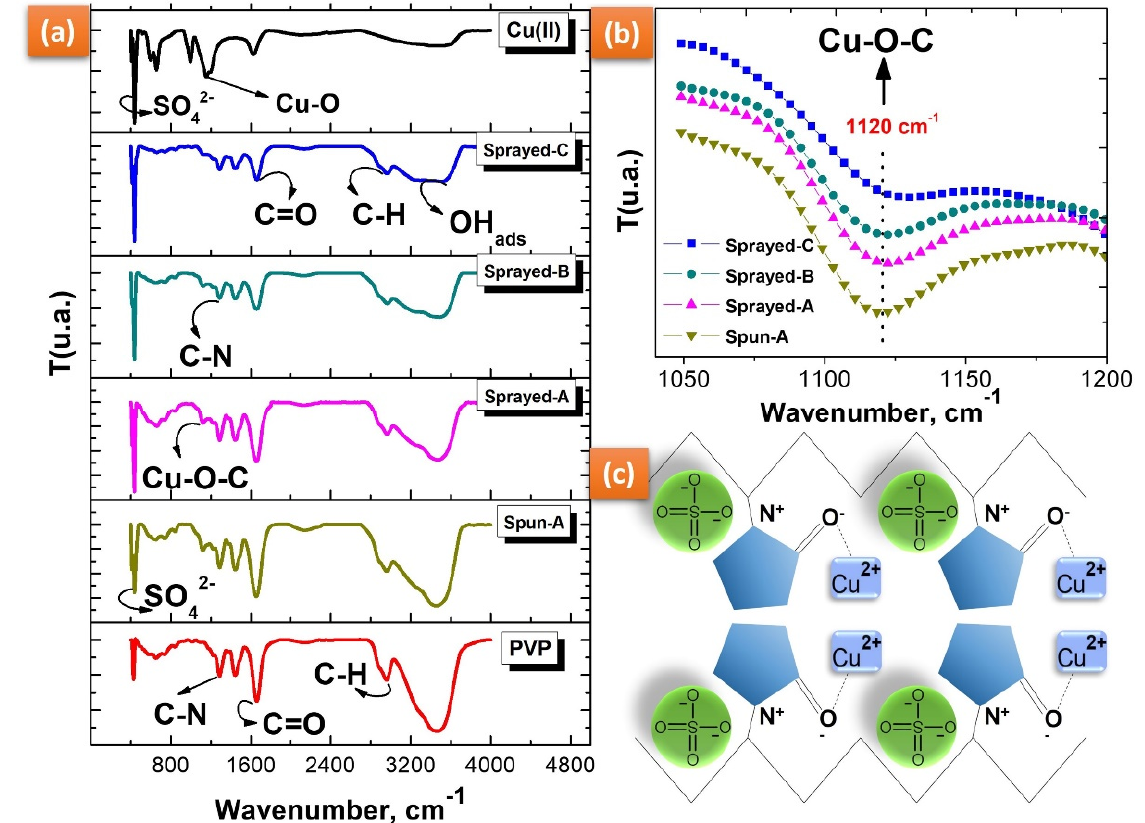
Figure 7. FTIR spectra of ( a ) pure copper salt (Cu (II)), pure PVP, spun A, sprayed A, sprayed B, and sprayed C after processing by electrospinning and electrospraying. FTIR spectra region from ( b ) 1050 to 1200 cm − 1 ( b ) and ( c ) schematic representation showing the interaction between Cu 2+ and PVP.